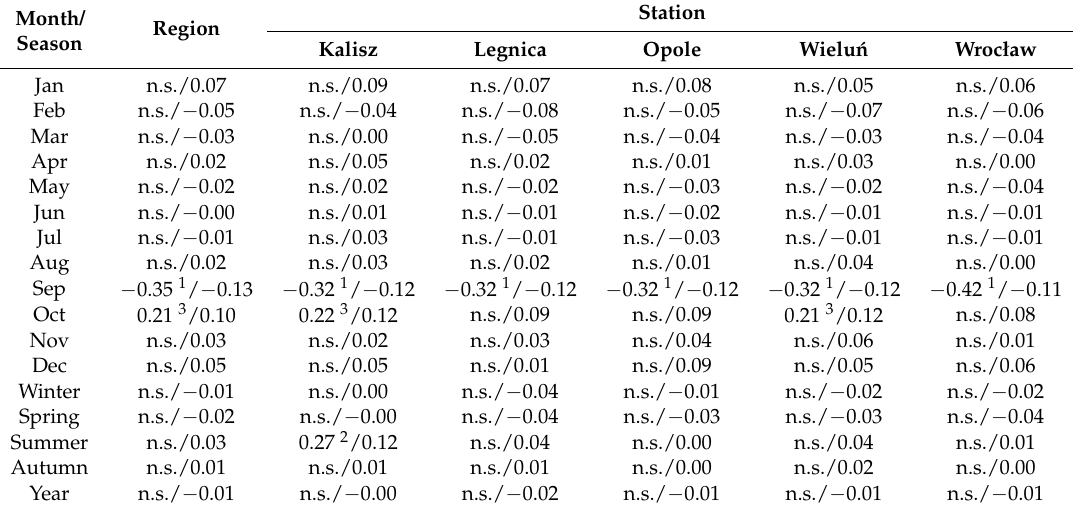
Table 6. Correlation coefficients for relationship between standard deviation of air temperature and the years 1951–2014, and the linear trend (in ◦ C/10